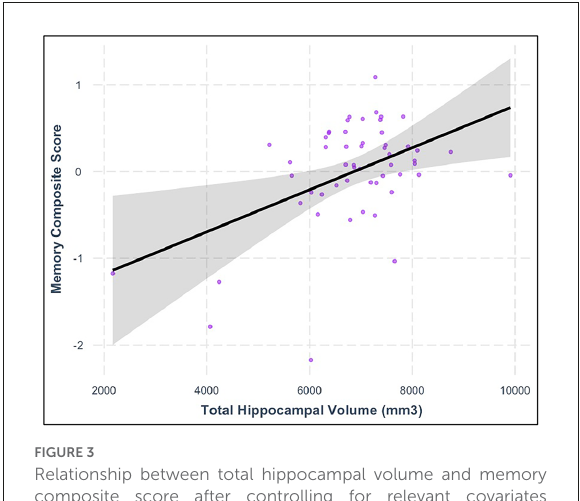
FIGURE3 Relationship between total hippocampal volume and memory composite score after controlling for relevant covariates ( β = 0.316, p = 0.017). The shaded area represents the 95% confidence interval for the regression model.